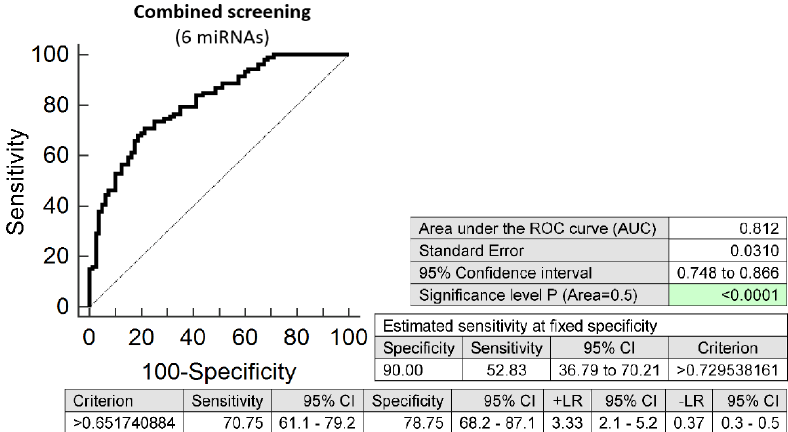
Figure 2. ROC analysis—the best minimal combination of microRNA biomarkers in early prediction of preterm delivery. The combination of miR-16-5p, miR-21-5p, miR-24-3p, miR-133a-3p, miR-155-5p, and miR-210-3p showed that at 10.0% FPR 52.83% preterm pregnancies had aberrant microRNA expression profile in the whole peripheral venous blood in early stages of gestation.